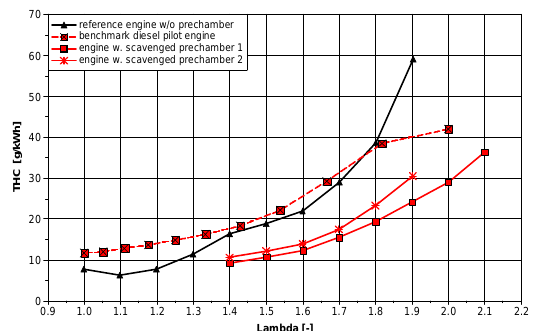
Fig. 20. Raw THC emissions for the operating point 1 (1400 rpm/50 Nm)